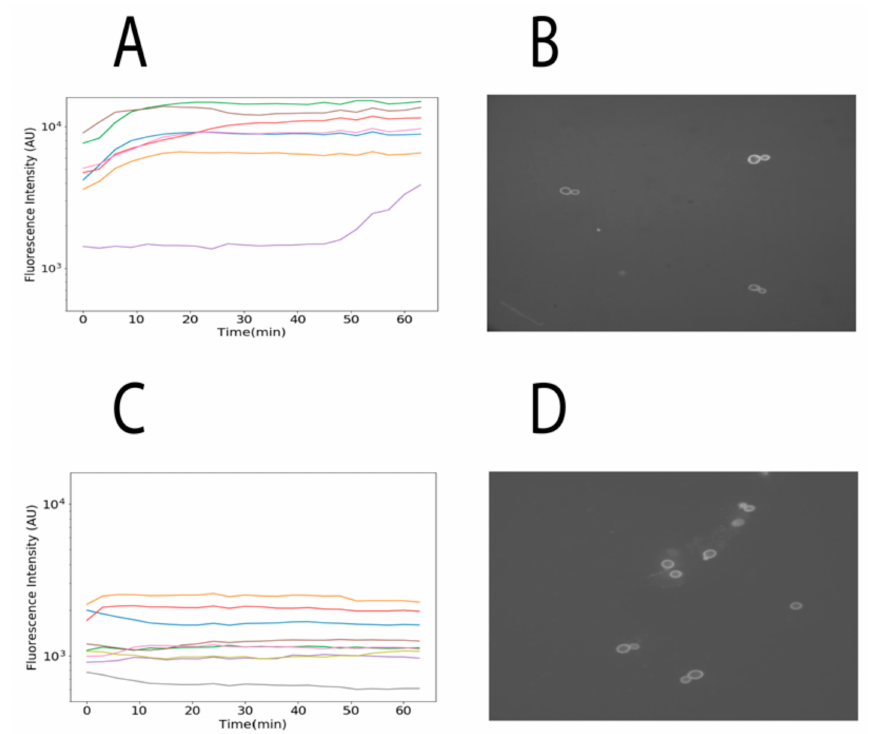
Figure 4. Internalization of α -NLS-C followed by confocal microscopy. ( A , C ) present the accumulated and normalized fluorescence intensities captured for each cell observed in the microscope for MATa and MAT α , respectively. ( B , D ) present the cells MATa and MAT α at the beginning of the experiment, respectively. Two sets of experiments were conducted; in this image we provide a summary of one of those experiments. The set of images captured each 3 min during 1 h are available at http://bis.ifc.unam.mx/ironbios/selmoonCPP/ (accessed on 21 July 2021) as Supplementary File